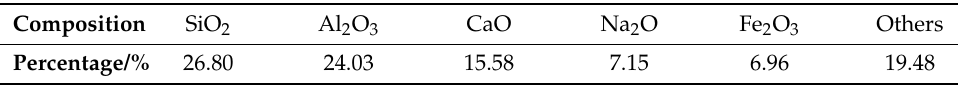
Table 3. Main chemical composition of red